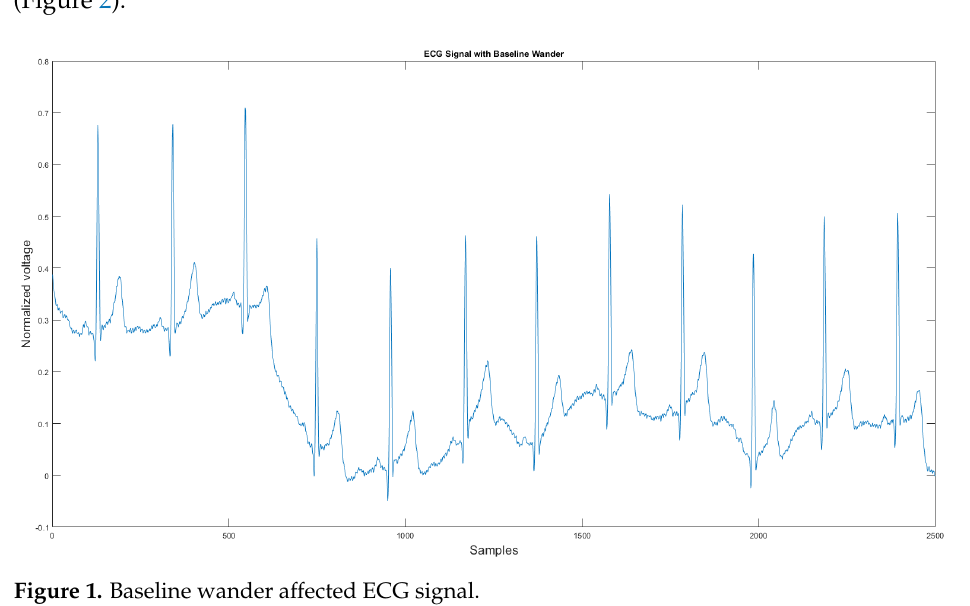
Figure 1. Baseline wander affected ECG signal.